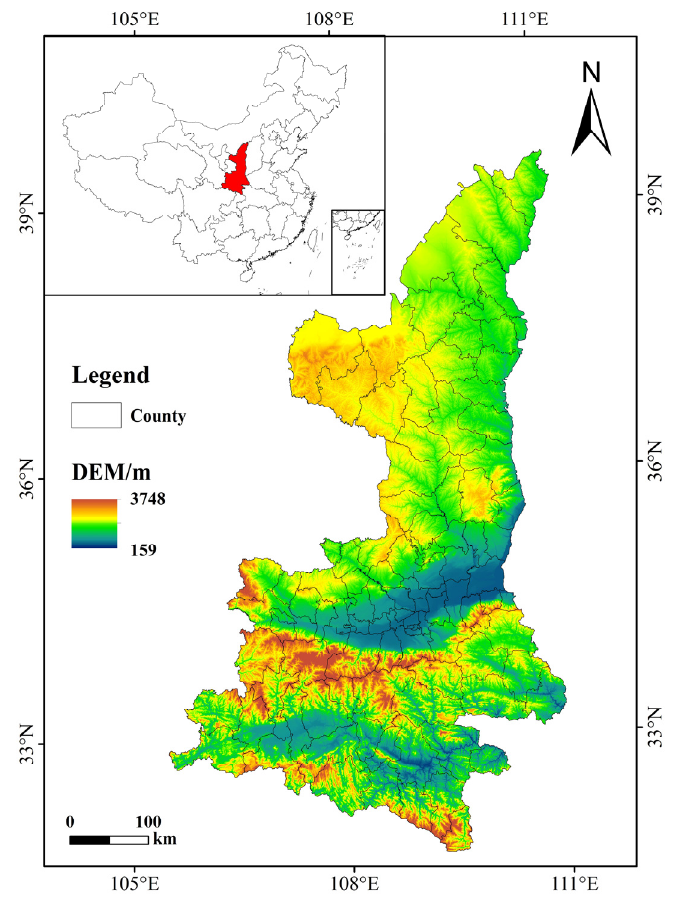
Figure 1. Study Figure 1. Study area.